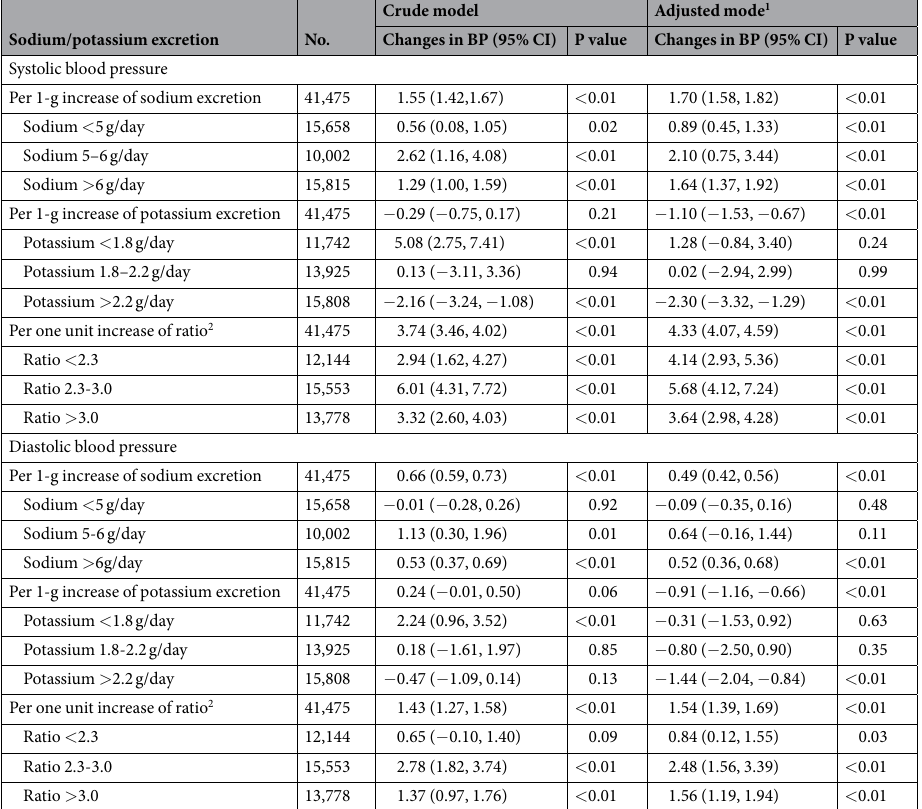
Table 2. Associations of blood pressure with 24-hour urinary sodium and potassium excretion per one-unit increase. Note: BP, blood pressure (mmHg); CI, confidence interval; 1 Adjusted for gender, age, education level, geographic region, body mass index (BMI), and alcohol intake; 2 Ratio meant 24-hour urinary sodium excretion divided by 24-hour urinary